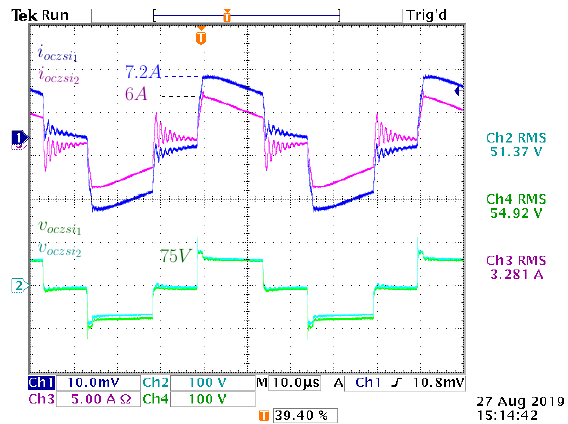
Figure 14. Multiport power imbalance test. Ch1 (10 mV/div=5 A/div): i oczsi Ch2 (100 V/div): v oczsi